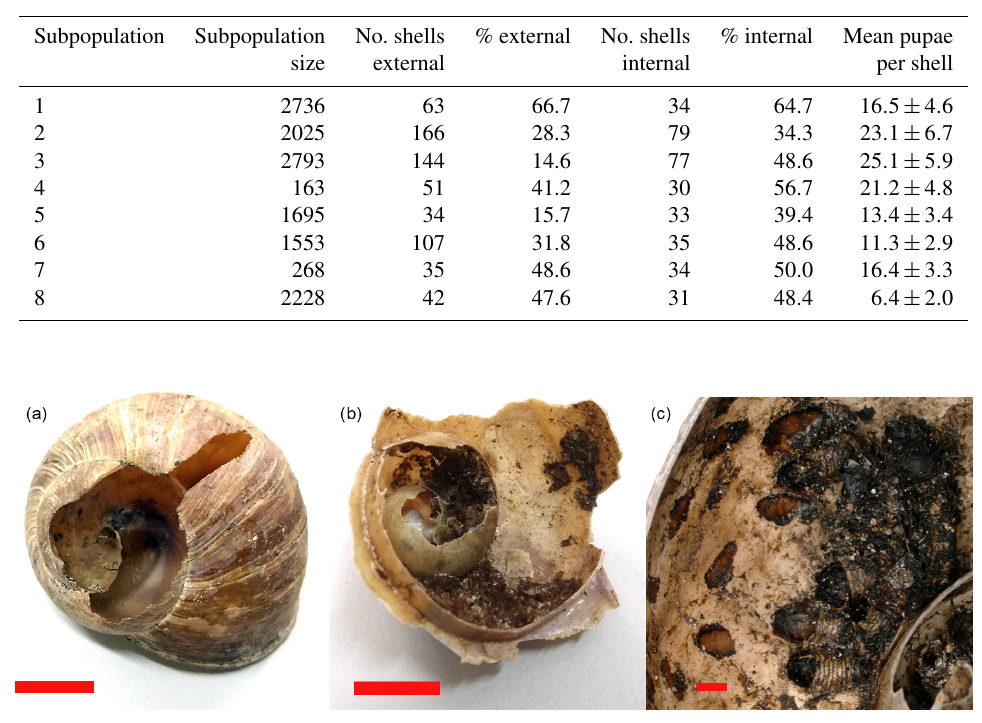
Table 1. The estimated subpopulation size, total number of shells examined (i.e. number of shells examined for external attack marks), percentage of shells with external attack marks, subset of shells examined for internal utilization marks, and percentage of shells with internal utilization marks. The final column shows the mean number of pupae observed per shell with internal utilization marks ± standard error of the mean.